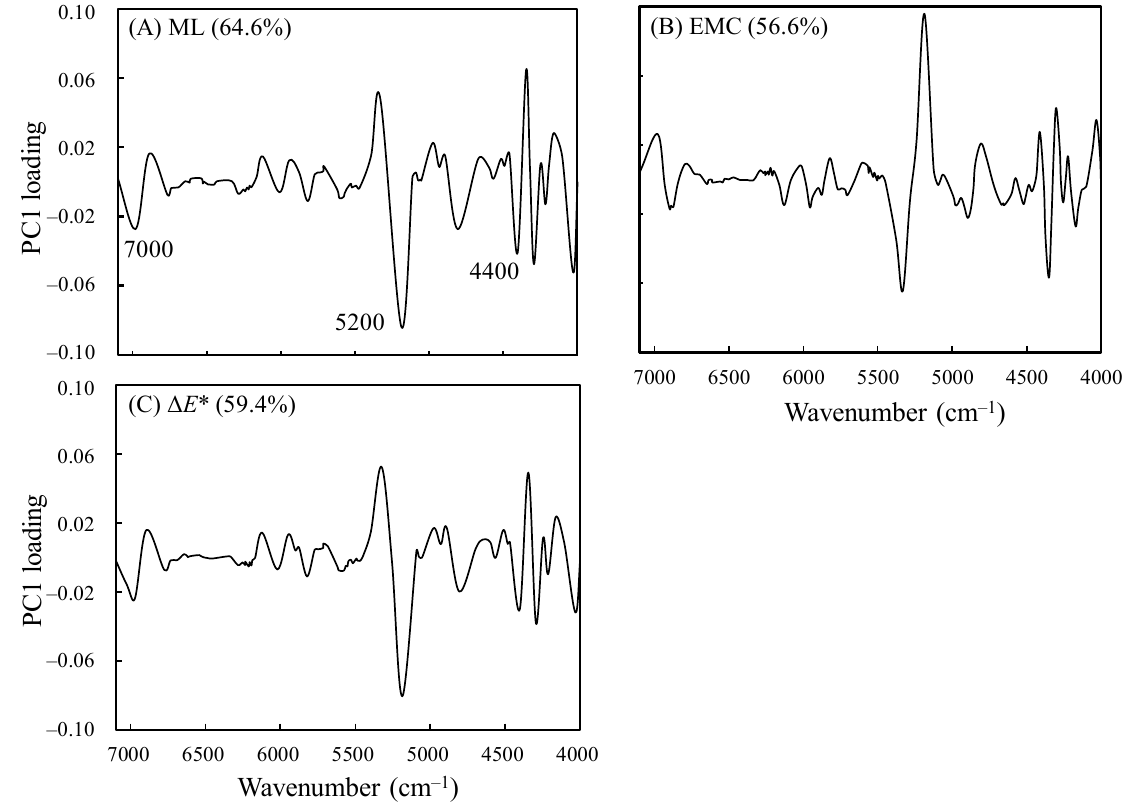
Figure 7. PC1 variable loading of the NIRS-based prediction model for ML ( A ), EMC ( B ), and Δ E * ( C ).